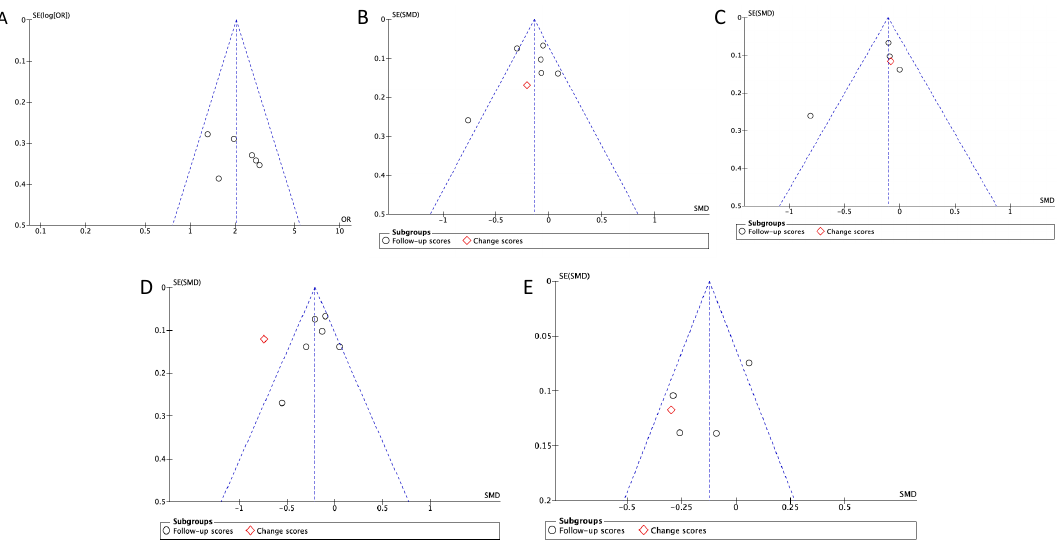
Figure 12. Funnel plots assessing asymmetry of biomedical outcomes between the PCMH care and Standard GP care. ( A )—Blood pressure (SMD); ( B )—Systolic blood pressure (OR); ( C )—Diastolic blood pressure (SMD); ( D )—HbA1C (OR); ( E )—LDL cholesterol.